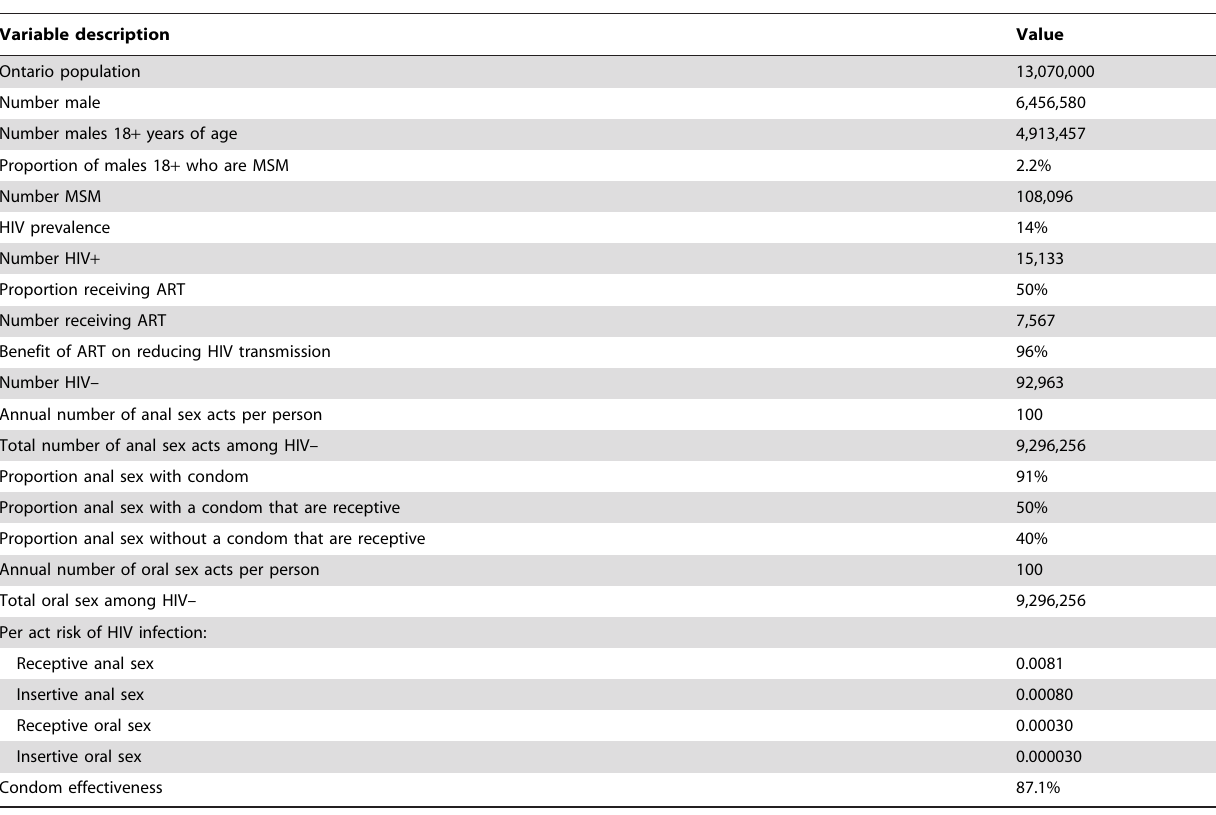
Table 1. Model parameter values.